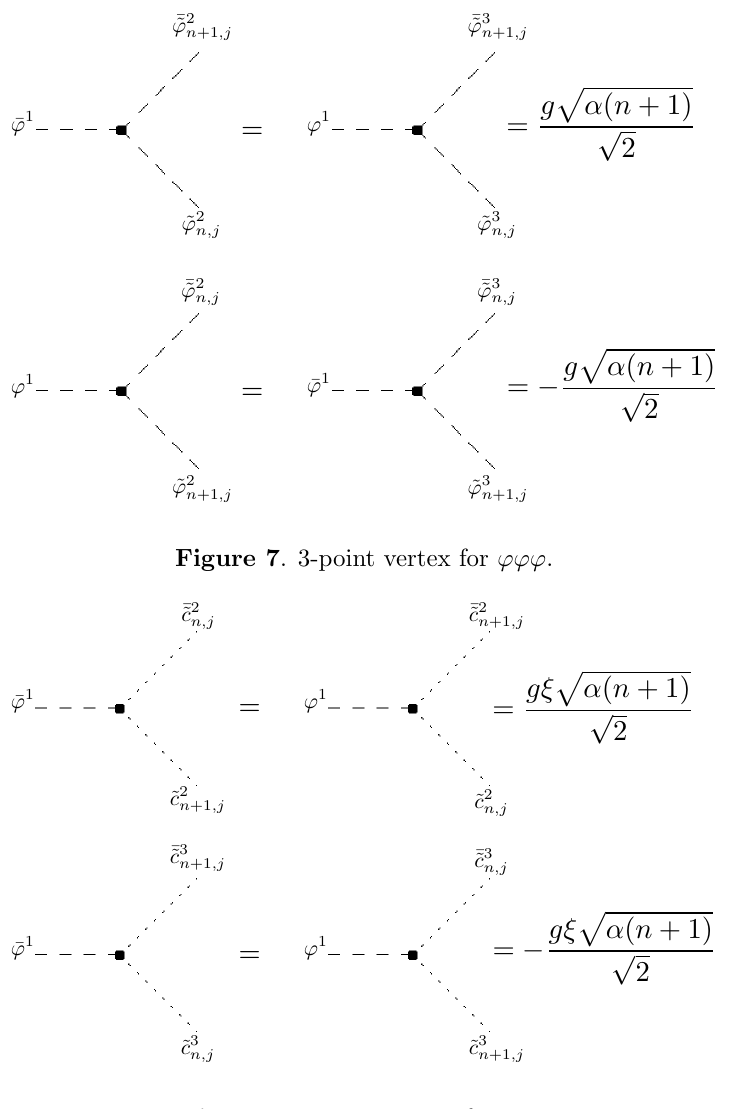
Figure 8 . 3-point vertex for ϕcc